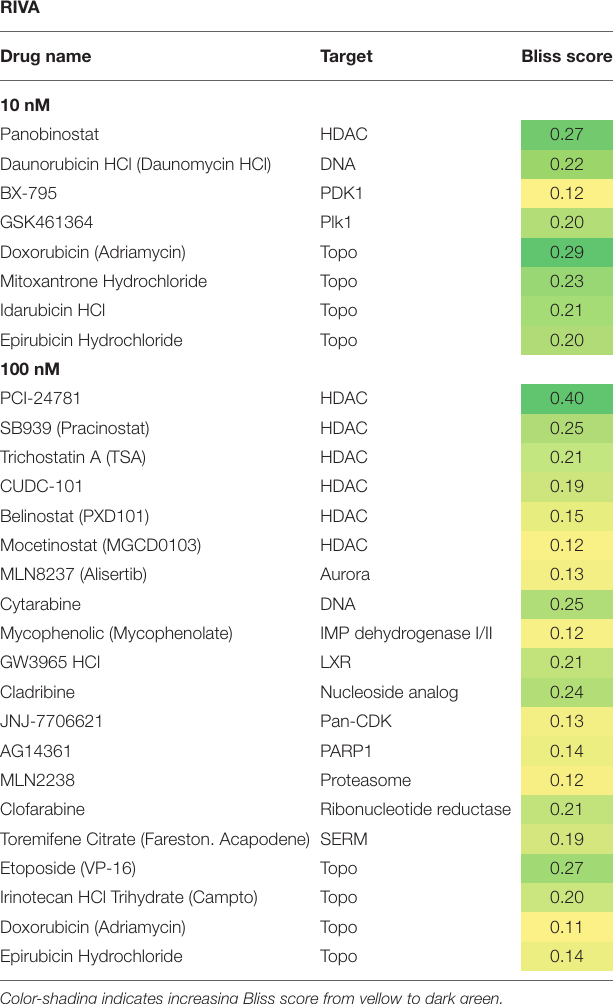
TABLE 3 | Hit candidate list from screen in RIVA cells.